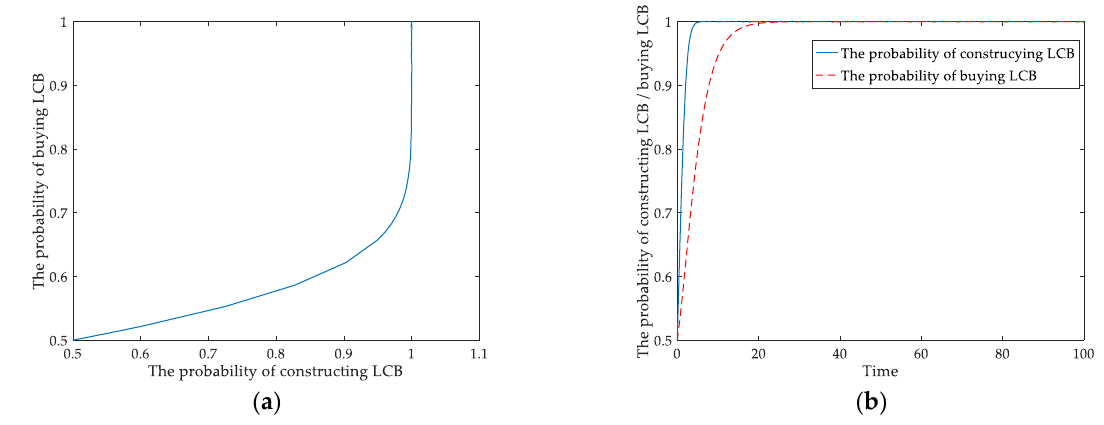
Figure 2. Evolutionary process under static model: ( a ) behavioral strategies; ( b ) the probabilities of behavior